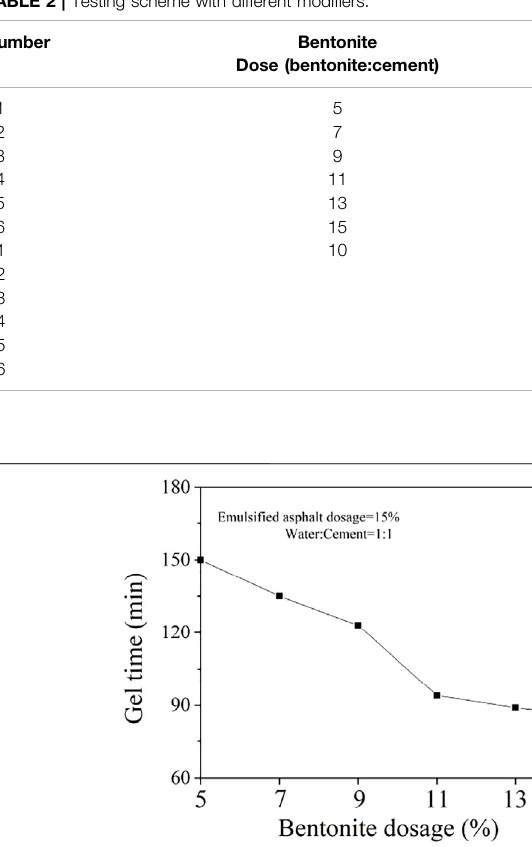
Frontiers in Earth Science |